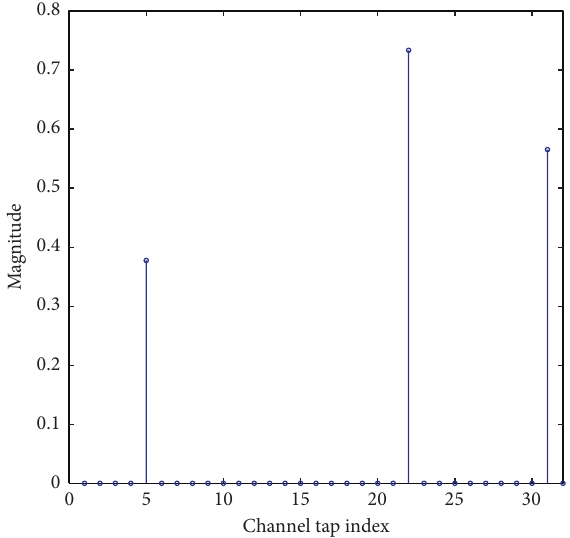
Figure 2: Typical sparse multipath